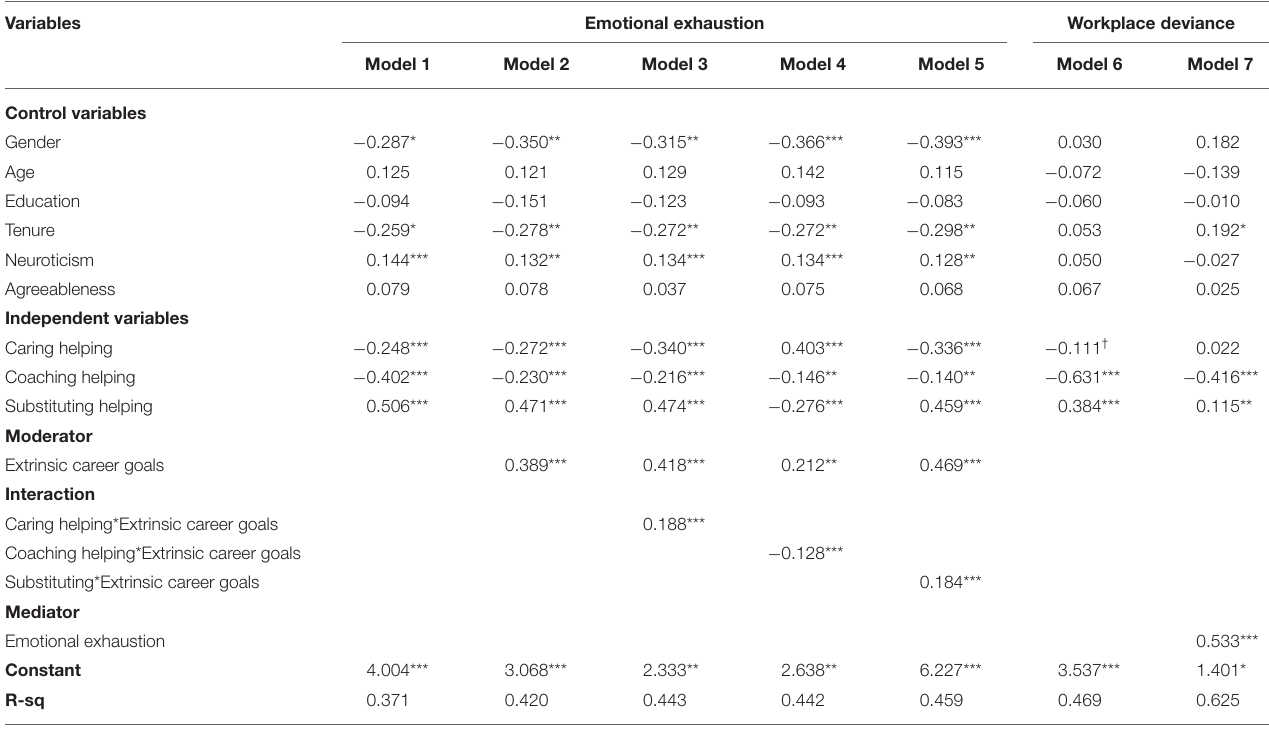
TABLE 3 | Results of hierarchical regression analyses.